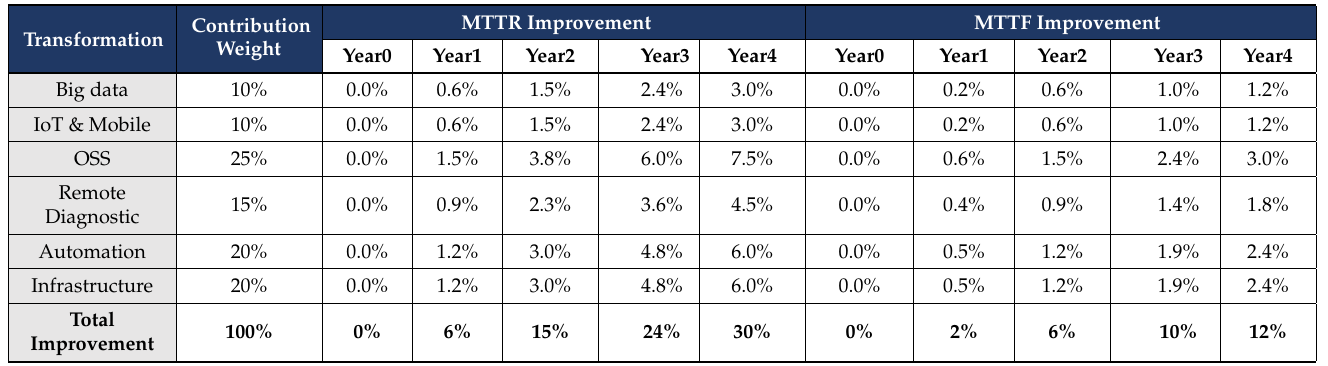
Table 2. Goals of